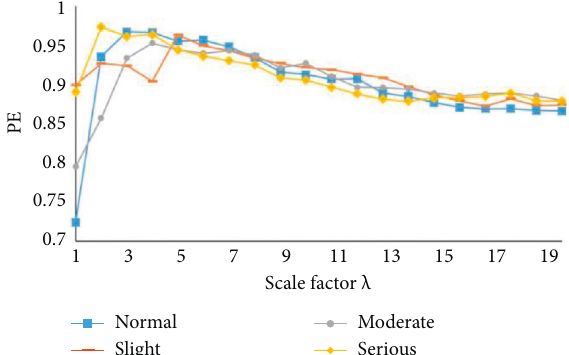
Figure 8: Permutation entropy of bearing vibration signals in different health states.